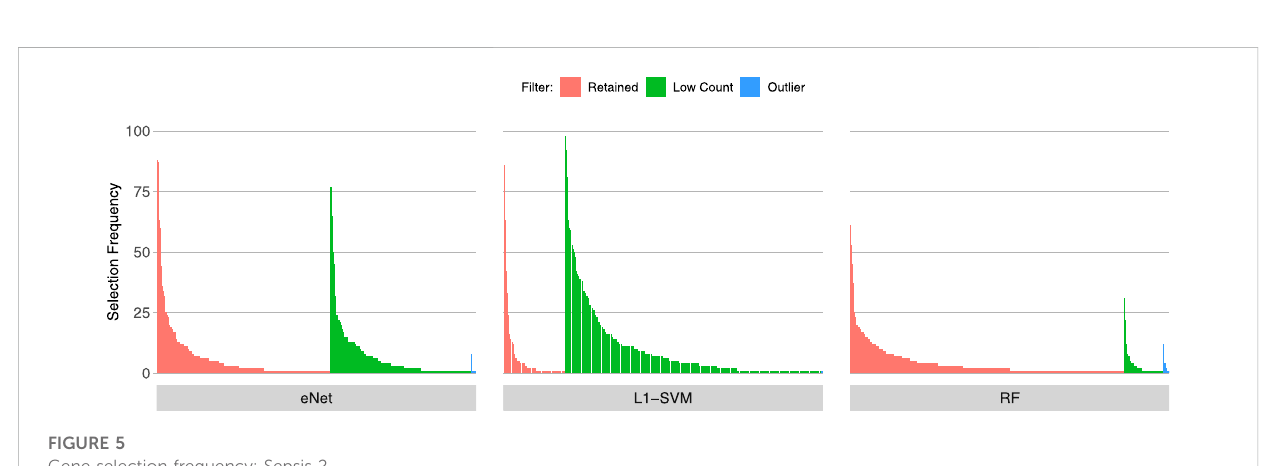
FIGURE 5 Gene selection frequency: Sepsis